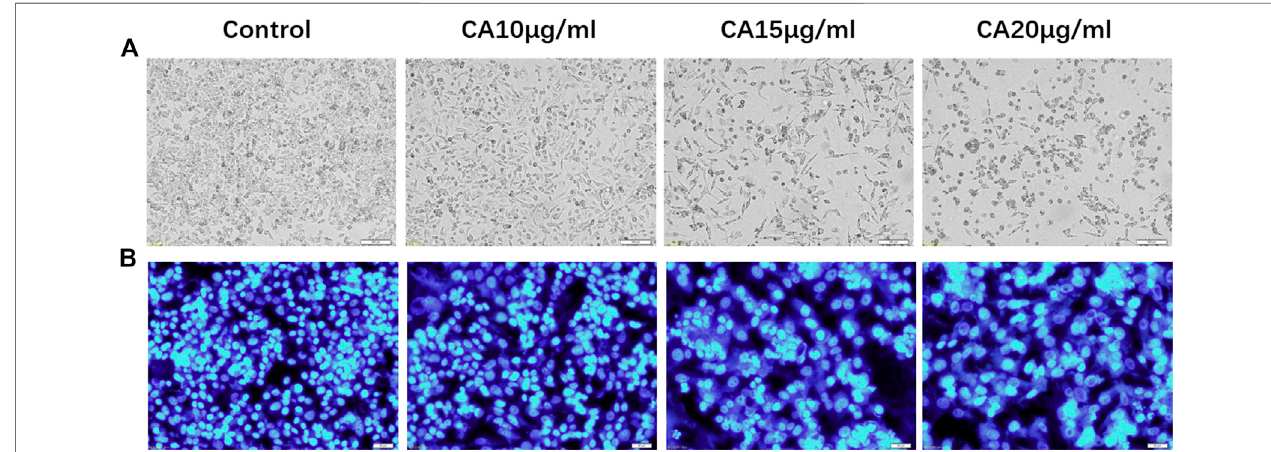
Frontiers in Pharmacology |